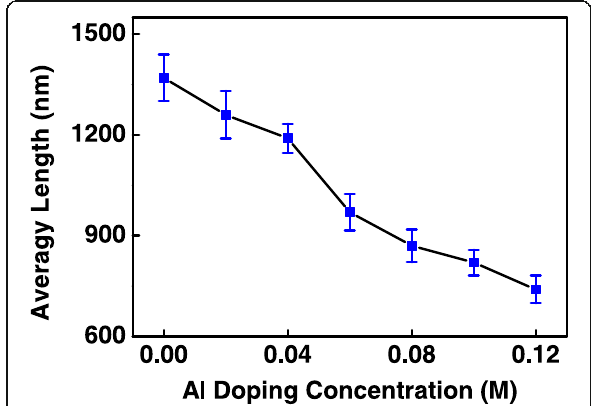
Fig. 2 The average length of AZO